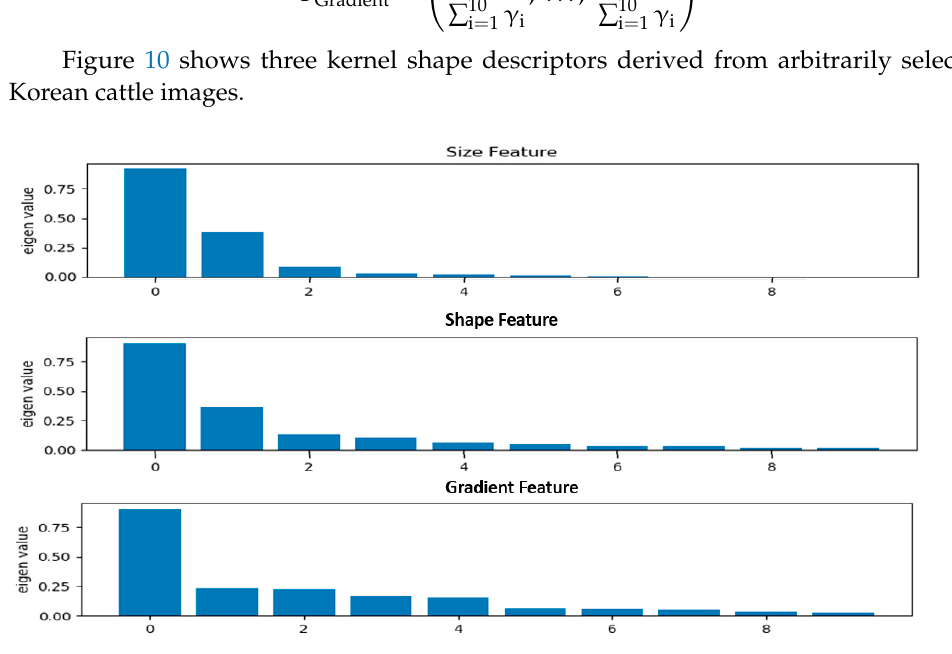
Figure 10. Three kernel shape descriptors derived from Korean cattle image.